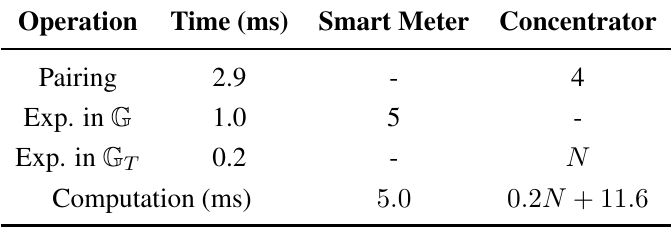
Table 3. Computation cost for signing and